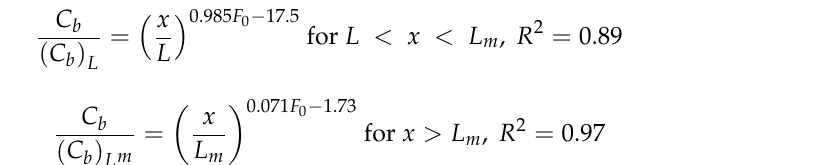
air concentration at x = L m .